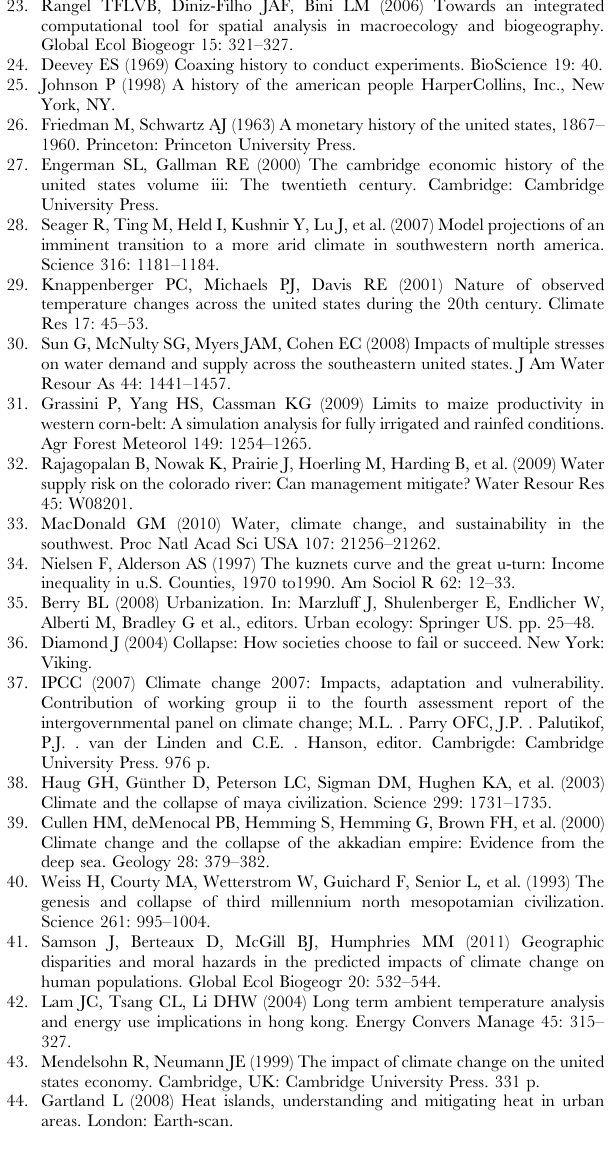
Figure S7 Standardized regression coefficients (Std b ) of the four least important predictors of demographic growth rates for 2728 U.S. counties in five 20-year intervals during the 20 th century (see Fig. 6). Counties shown in white were not included in the analyses because they did not have consistent census data or changed their geographical boundaries during the 20 th century. See fig. 6 for the Std b of the four other variables used in this analysis. Table S1 Model selection with Akaike information criterion (AIC) of stationary (OLS) and non-stationary (GWR) regression models predicting demographic growth rates for 2728 U.S. counties in the 20 th century based on climatic (C) and/or non-climatic (NC) predic- tors. The AICc weigths of the GWR C + NC models were always